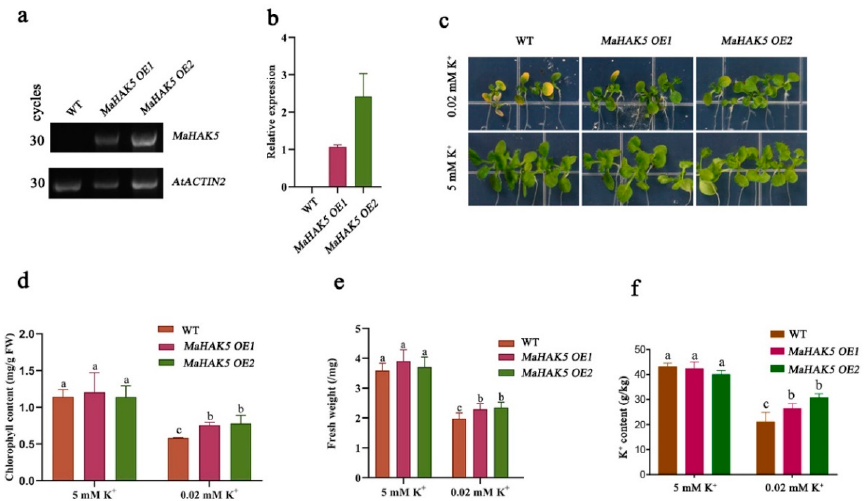
Figure 5. Functional characterization of MaHAK5 in Arabidopsis . ( a ) semiquantitative RT ‐ PCR and ( b ) qRT-PCR of MaHAK5 in WT and two transgenic Arabidopsis lines. AtACTIN2 was used as the reference gene. Data are shown as means ± SE (n = 3). ( c ) Leaf chlorosis phenotypes of WT and transgenic Arabidopsis lines after being grown with 0.02 mM K + (upper panel) and 5 mM K + (lower panel) for 14 d. ( d ) Chlorophyll content and ( e ) fresh weight of WT and transgenic Arabidopsis lines grown on MS medium with different K + concentrations for 14 d. Data are the means ±SE of 3 assays. ( f ) K + content in WT and transgenic Arabidopsis lines grown on MS medium with different K + concentrations for 7 d. Data are the means ±SE of 3 assays. Statistical significance was determined using student’s t ‐ test ( p < 0.05), lowercase letters above the bars in (a), (b) and (c) indicate significant differences between multiple groups.